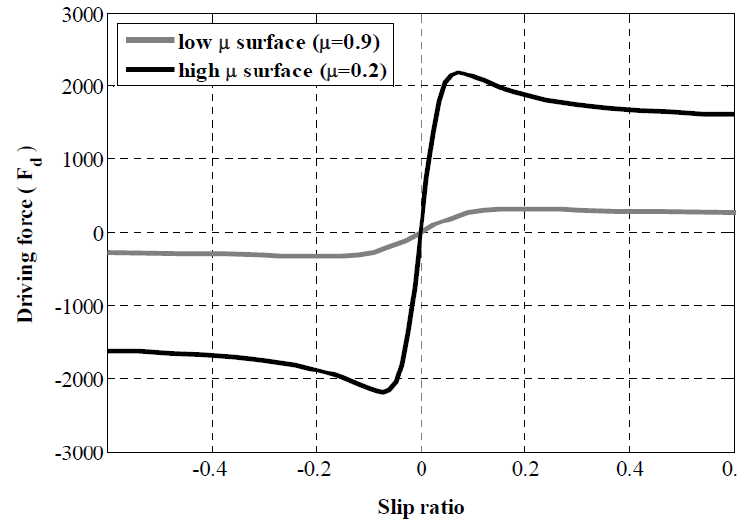
Figure 1. Vehicle driving force and slip ratio relationship [11].